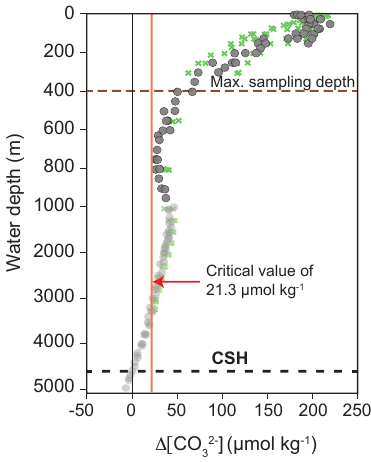
Figure 4. Calcite saturation state indicated by (cid:49) [CO 2 − ] depth 3 profiles of the Caribbean Sea and Gulf of Mexico. Grey dots and green crosses indicate the transects A22 (stations 10–15) and NACPECC (stations 20–28) (Fig. 1) with (cid:49) [CO 2 − ] being the dif- 3 ference between [CO 2 − ] in situ and [CO 2 − ] saturation . Alkalinity and 3 3 TCO 2 were taken from WOCE and NACP (https://cchdo.ucsd.edu/, last access: 21 November 2018; cruise RV Knorr in 1997, EX- POCODE: 316N151_4 and cruise RV Ronald H. Brown in 2007, EXPOCODE: 33RO20070710) to calculate [CO 2 − ] in situ using the 3 program CO2SYS (Pierrot et al., 2006; taking the constants ( K 1 and K 2 ) of Mehrbach et al., 1973 refitted by Dickson and Millero, 1987 and ( K SO ) from Dickson, 1990). [CO 2 − ] saturation was cal- 3 4 culated after Jansen et al. (2002). The red vertical line indicates the critical (cid:49) [CO 2 − ] value of 21.3µmolkg − 1 , below which selective 3 Mg 2 + ion removal starts (Regenberg et al., 2014); the black dashed line marks the calcite saturation horizon (CSH), which is defined as 0µmolkg − 1 and represents the top of the lysocline at ∼ 4600m water depth; the brown dashed line indicates the maximum plankton tow sampling